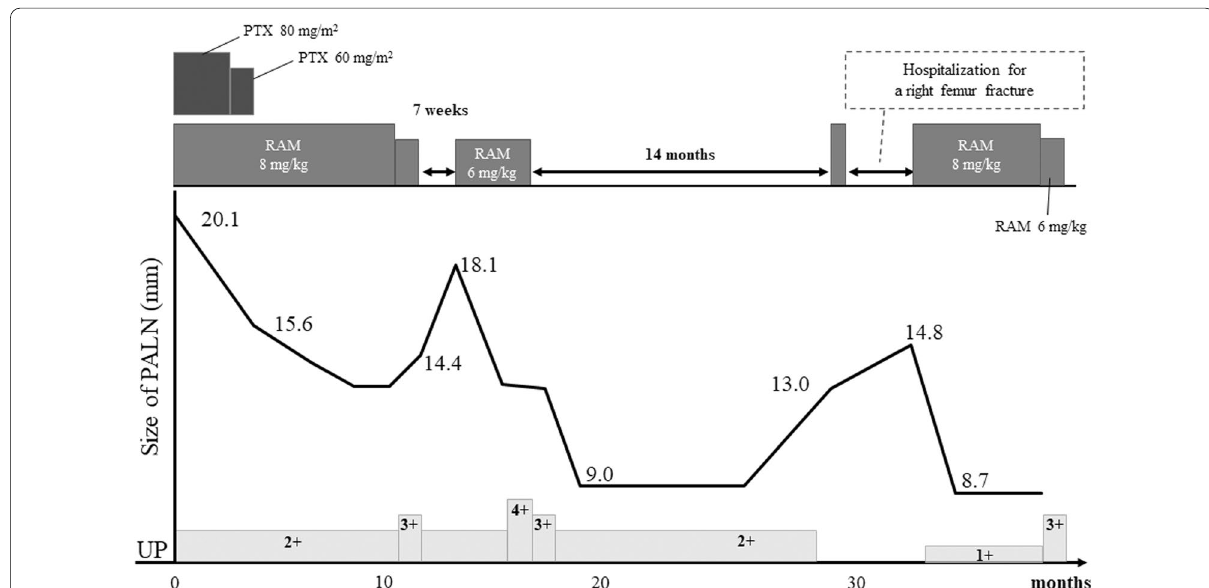
Fig. 5 Timeline of this patient after the initiation of second-line chemotherapy with PTX plus RAM. Although the recurrent No. 16b1 lymph node grew during RAM’s withdrawal period, it shrank again after resumed